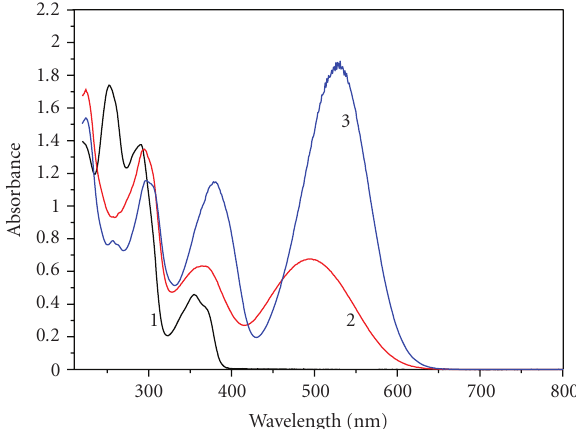
Figure 5: Absorption spectra of the compound 5a in acetonitrile ( C = 4,82 × 10 − 5 M, T = 30 ◦ C) before (1), immediately after (2) and 20 seconds after (3) addition of zinc salt ([Zn ++ ] = 1,12 × 10 − 3 ).